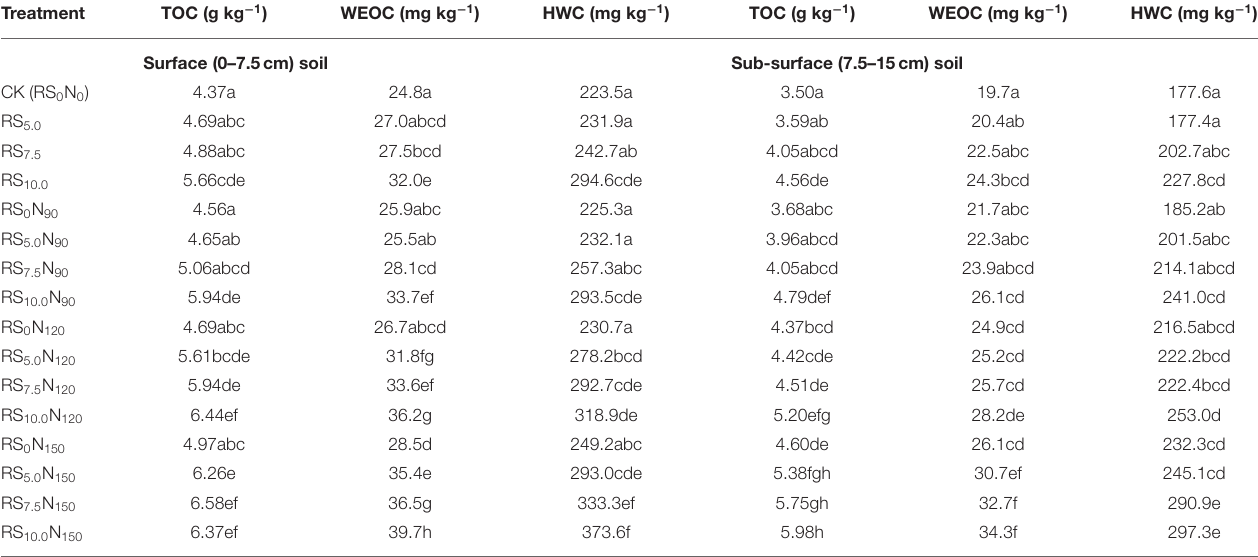
TABLE 4 | Effect of fertilizer-N application and rice straw (RS) incorporation on total organic carbon (TOC), water extractable organic carbon (WEOC) and hot water carbon (HWC) in surface (0–7.5cm) and sub-surface (7.5–15cm) soil depth under rice-wheat cropping system in north-western India.